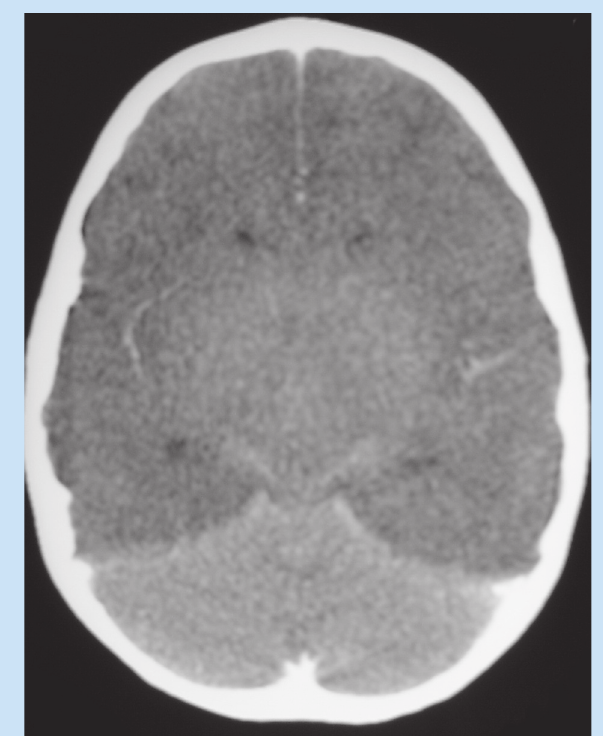
Fig. 2.2a. The bright cerebellum sign indicates normal appearance of the posterior fossa structures with severe oedema of the supratentorial brain resulting in low density, loss of grey/white interface and obliteration of sur- face markings and sulci.